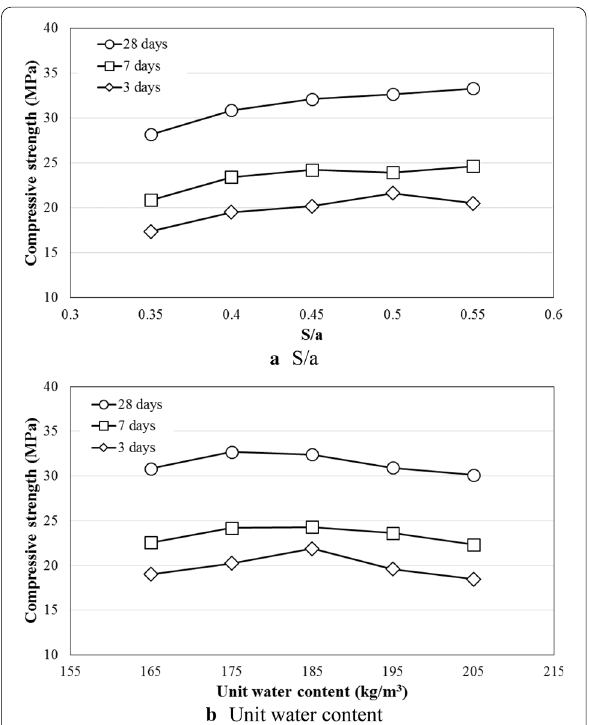
Fig. 9 Effects of S/a and unit water content on compressive strength of normal concrete mixture depending on age. Each data point represents an averaged value from five‑unit water content cases and S/a cases for the graph of S/a and the graph of unit water content,